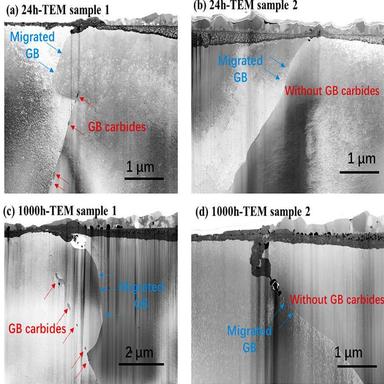
HAADF images of TEM foils after exposure in SCW at 600 ◦C for 24 h and 1000 h, (a) and (c) shows the GB carbides did not move with the GB migration, (b) and (d) shows the GB migration and oxidation occurred on GBs without carbides.